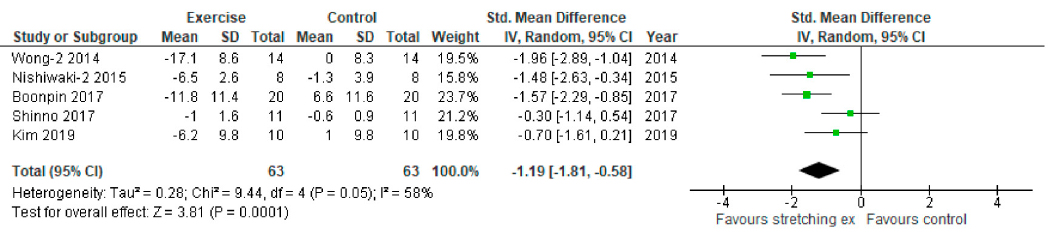
Figure 4. Sensitivity analysis with different assessments of outcome comparing changes in arterial stiffness following stretching exercises to non-exercise controls (sensitivity analysis-2 for primary outcome). SD, standard deviation; IV, inverse variance; CI, confidence interval; Std, standardized.